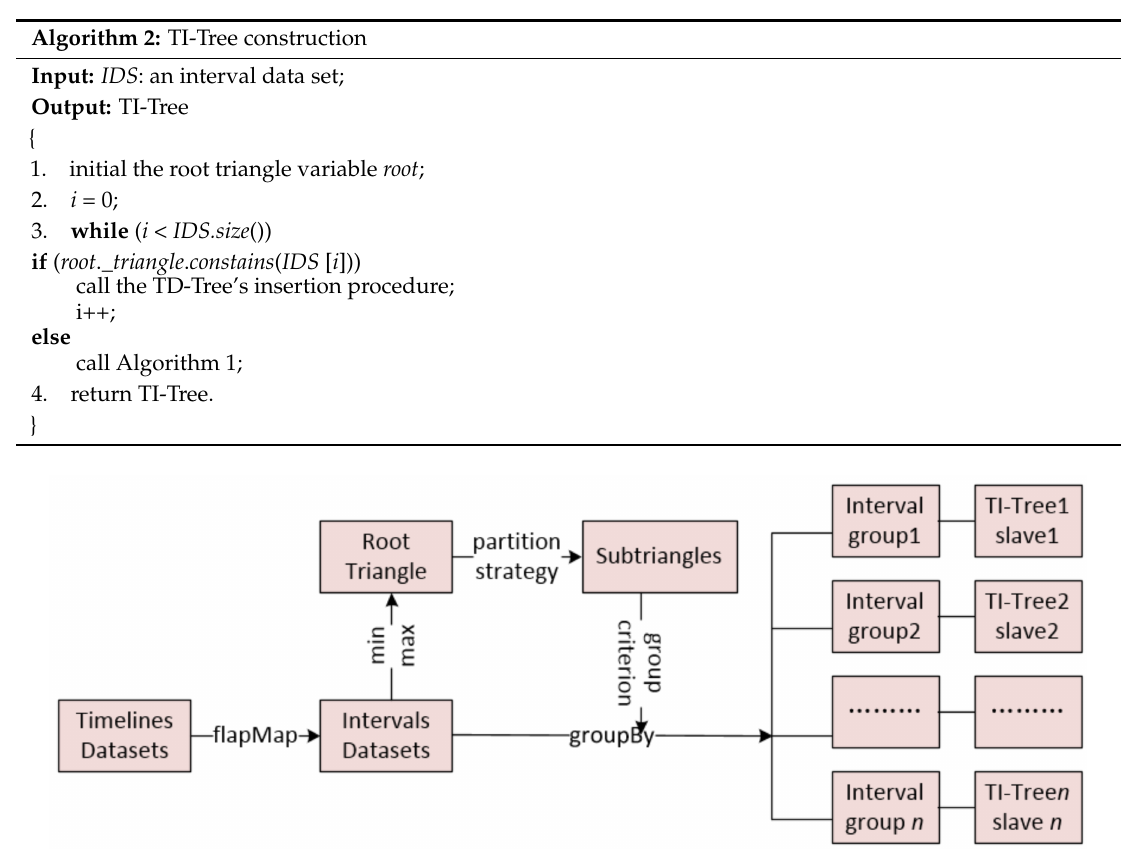
Figure 10. DTI-Tree construction